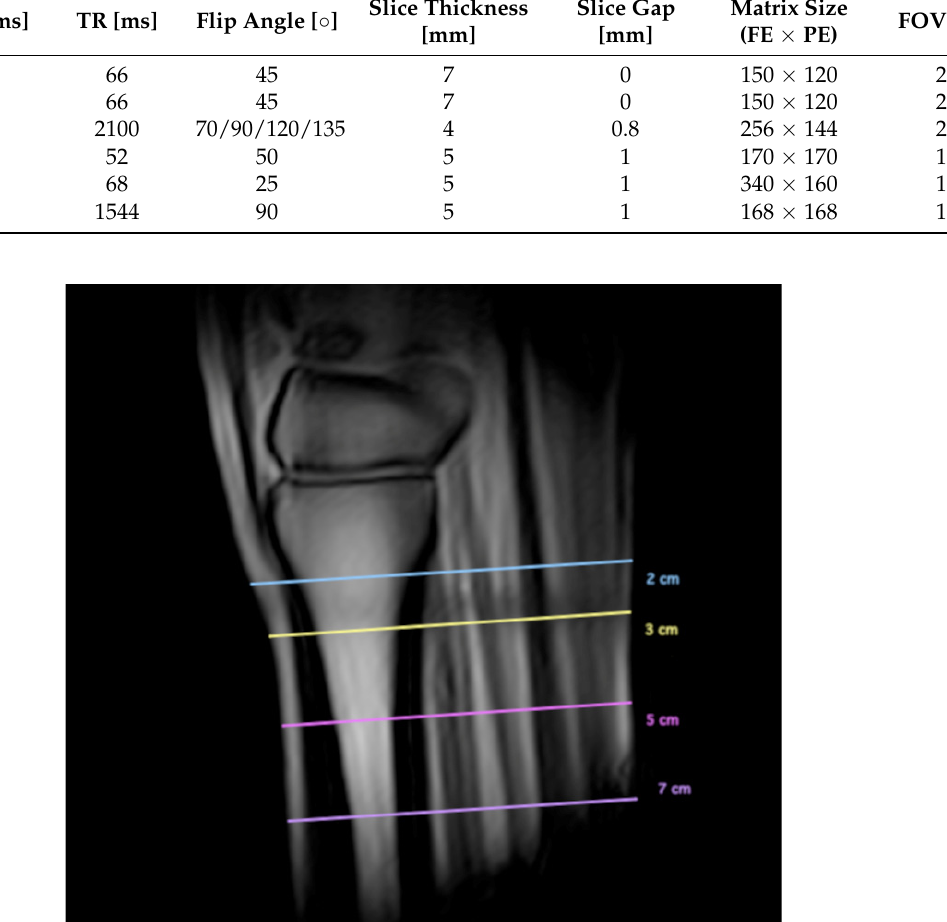
Figure 2. Midline sagittal image from the pilot scan, depicting how the levels were set at 2, 3, 5, and 7 cm distal to the carpometacarpal joint, perpendicular to the suspensory ligament.